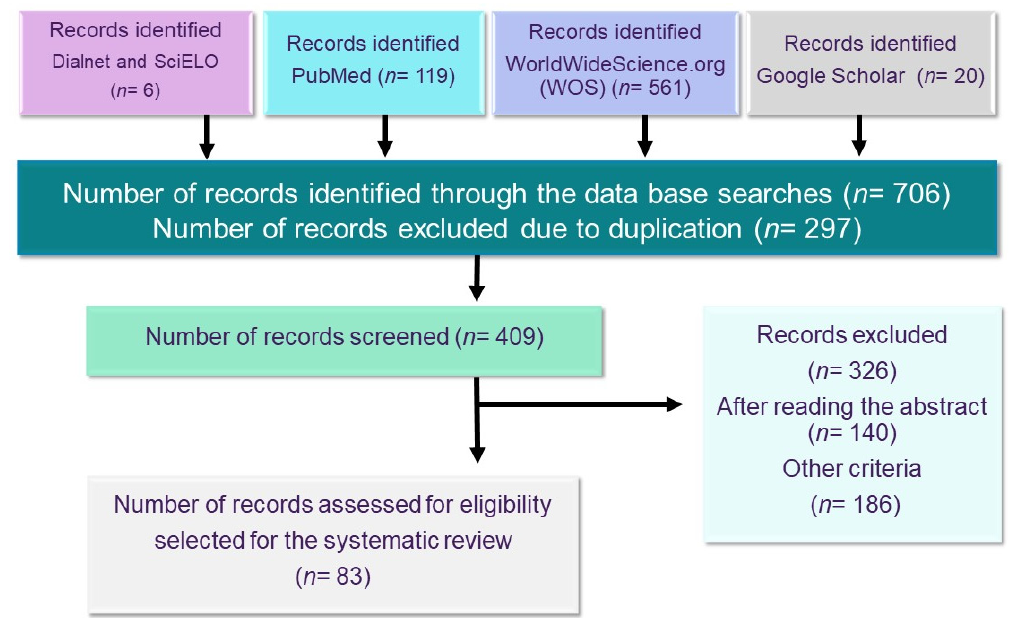
Figure 2. Flow chart of the systematic review on misophonia.